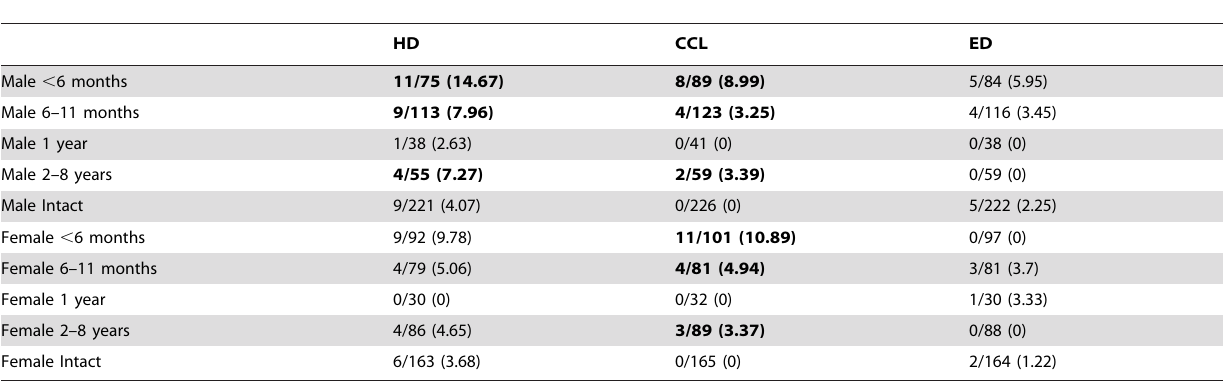
Table 2. Golden Retriever males and females, joint disorders.